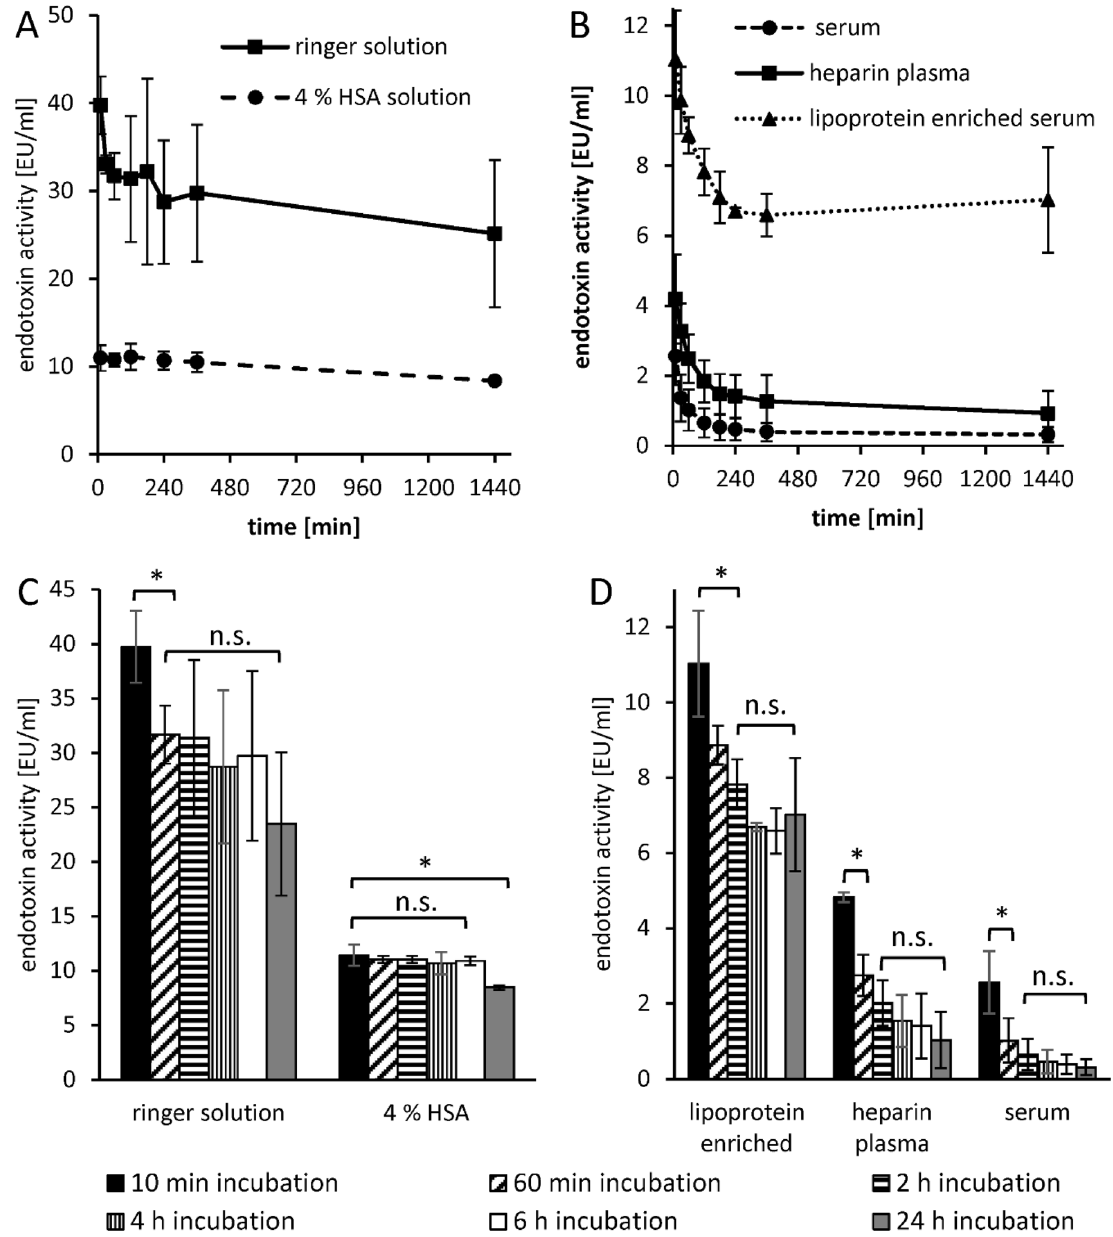
Figure 8. Endotoxin neutralization as a function of incubation time in different media. To check whether endotoxin neutralization in different media is time-dependent, 5 ng/mL LPS ( E. coli ) were incubated in different solutions for 24 h (reverse mode) and the endotoxin recovery was measured by LAL test. The kinetic LPS neutralization was tested in ringer solution and ringer solution containing 4% (w/v) human serum albumin ( A ). Fresh human serum, heparin plasma and lipoprotein-enriched serum were also included in this study ( B ). The bars marked with * indicate from which incubation time of LPS a significant (p ≤ 0.05) endotoxin reduction is achieved compared to the 10 min sample (C and D). n.s. not significant. Mean ± standard deviation of three independent experiments are